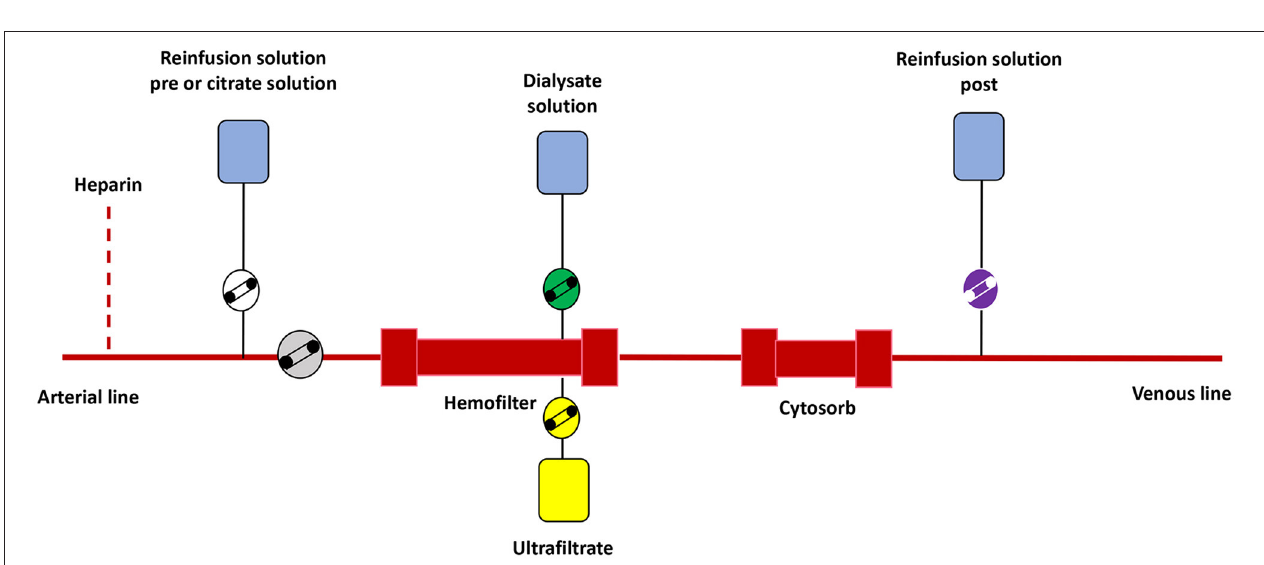
FIGURE 2 | Graphical schema of the extracorporeal blood purification circuit.